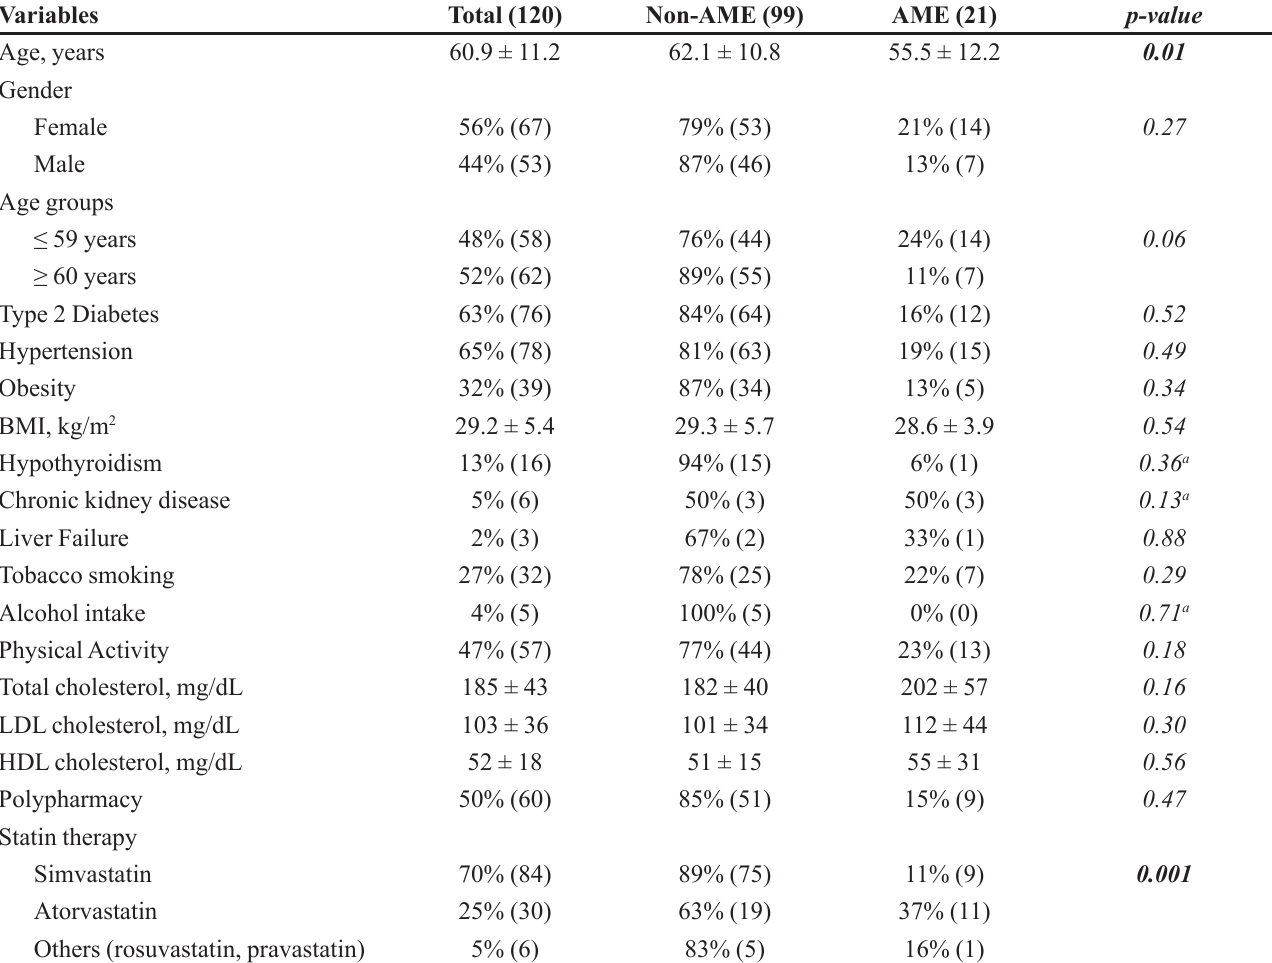
TABLE I - Demographic and clinical characteristics of dyslipidemic outpatients